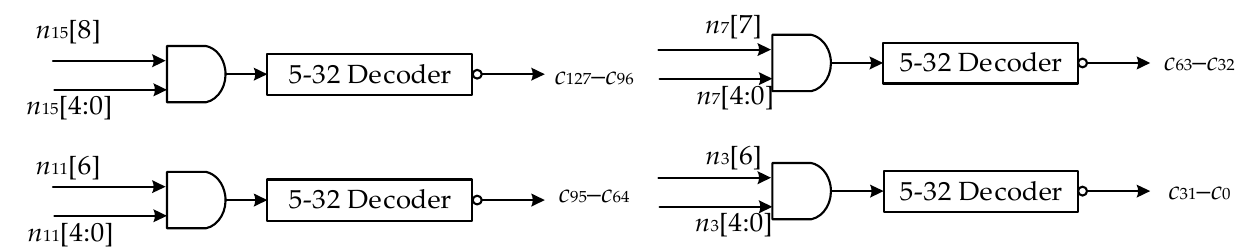
Adjust the difference caused by the shift bit-width through the xor gate. Figure 10 shows the control information generation module of the and layer. RSTU supports the logical shift in 32-bit granularity. The control information of every 32 and gate is composed of one and gate and 5–32 decoders, similar to the SWC . Different from Figure 10. Generating module of the AND layer control information. Figure 10. Generating module of the AND layer control the generation module, the function of the decoder is to translate the 5-bit binary input into 32-bit decimal output, according to the principle of filling “0” from the lowest posi- tion.